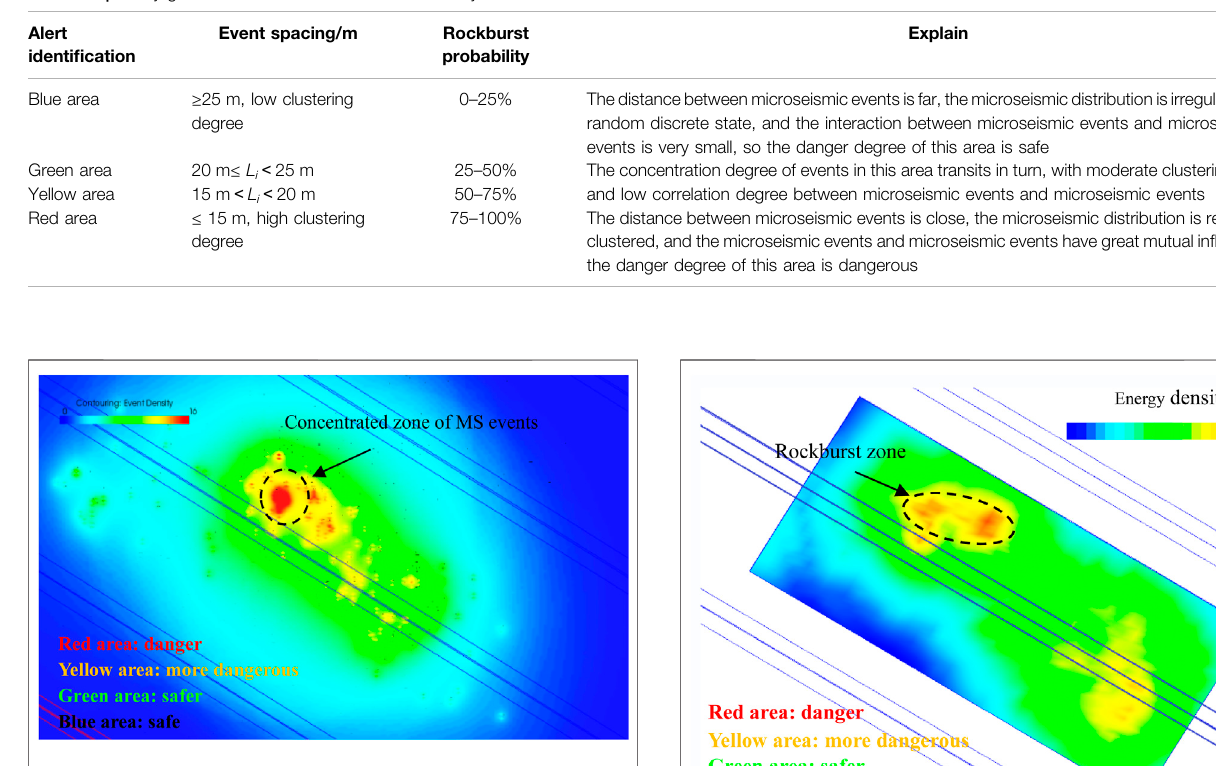
FIGURE 4 | Rockburst hazard zoning by the contour of microseismic events.